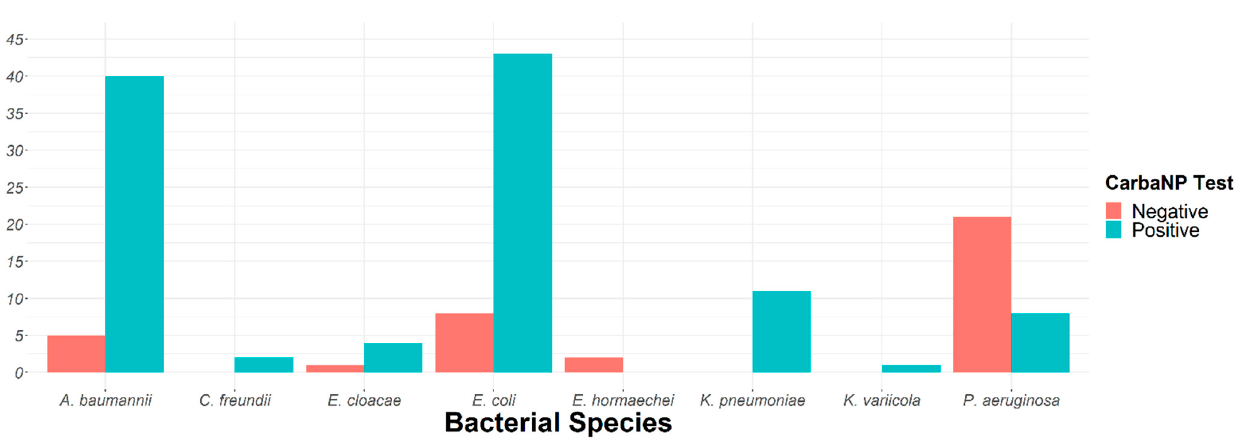
Figure 2. Carba NP test ( Enterobacterales and P. aeruginosa ) and CarbAcineto ( A. baumannii ) test re- sults.